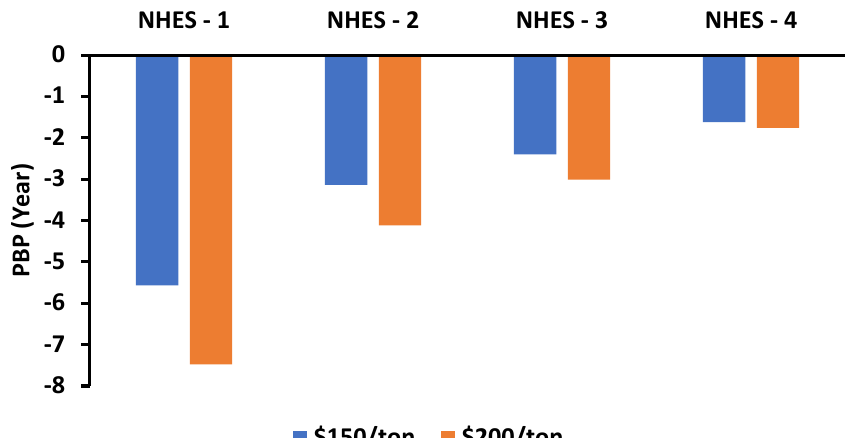
Figure 22. Difference in PBP based on increased carbon tax for Southwest region.